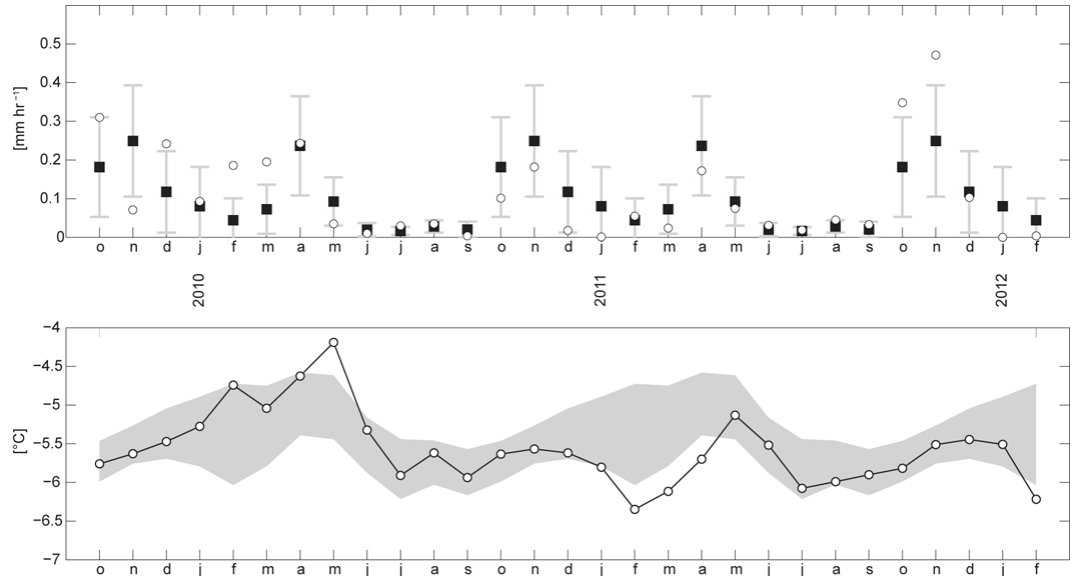
Fig. 3. Upper panel: Monthly TRMM precipitation rates for the study period (open circles) relative to the January 1998–July 2012 mean (black squares) and monthly standard deviations (gray error bars) for the grid point nearest Mt Kenya. Lower panel: Monthly ERA-Interim 500hPa air temperature averaged over 36.5 to 38.5 ◦ E and − 1 to 1 ◦ N for the measurement period (open circles) relative to the range of the monthly mean temperature for January 1979–July 2012 ± 1 monthly standard deviation (gray